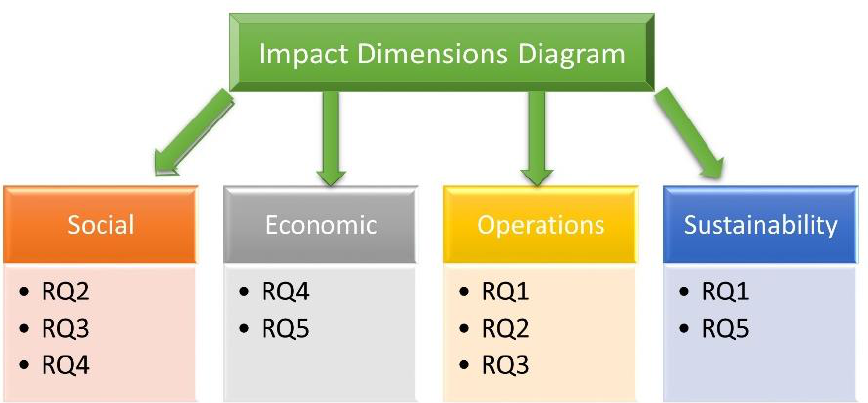
Figure 3. Relationship between Impact Dimensions and Research Questions. Table 1. Comparative analysis of recent works in food traceability and safety.